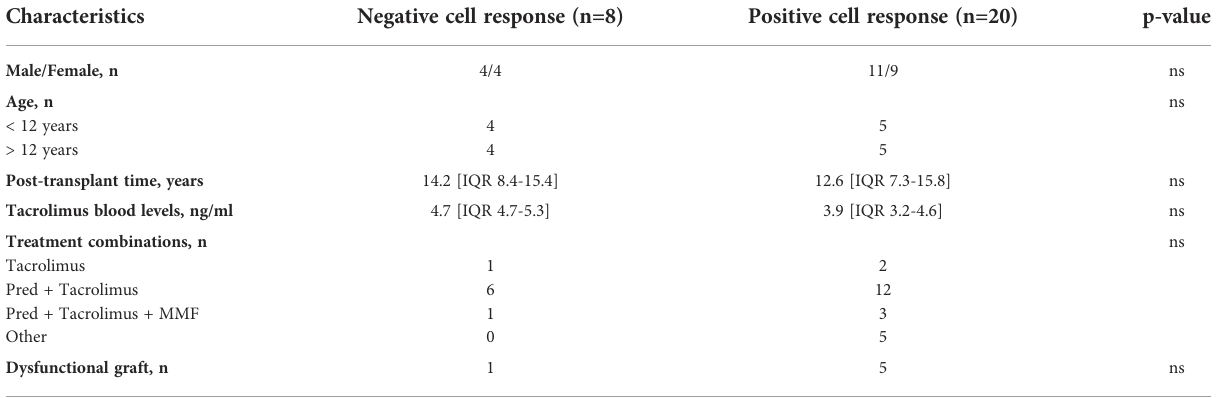
TABLE 2 Epidemiologic and clinical features in patients with negative and positive cell responses after receiving the second vaccine dose.